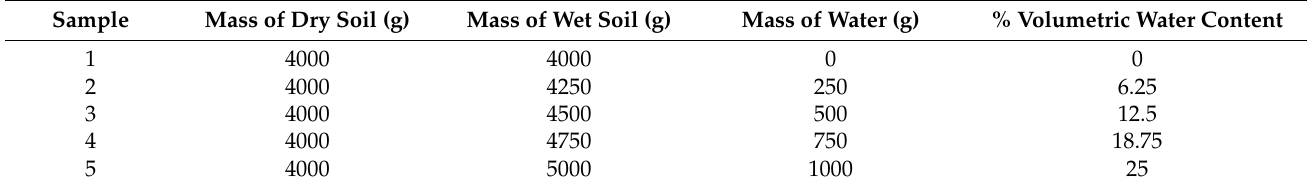
Table 3. Samples used during the